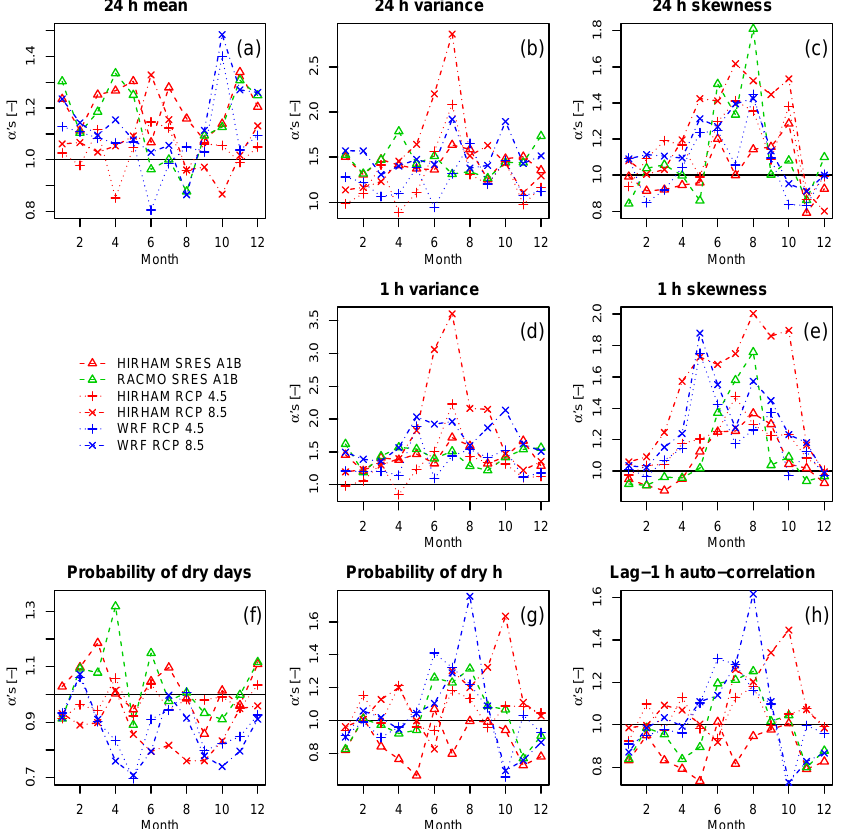
Figure 10. Change factors, α ’s, calculated on a monthly basis for each statistic and each RCM. Each set of α ’s from an RCM act as a perturbation scheme for the WG.